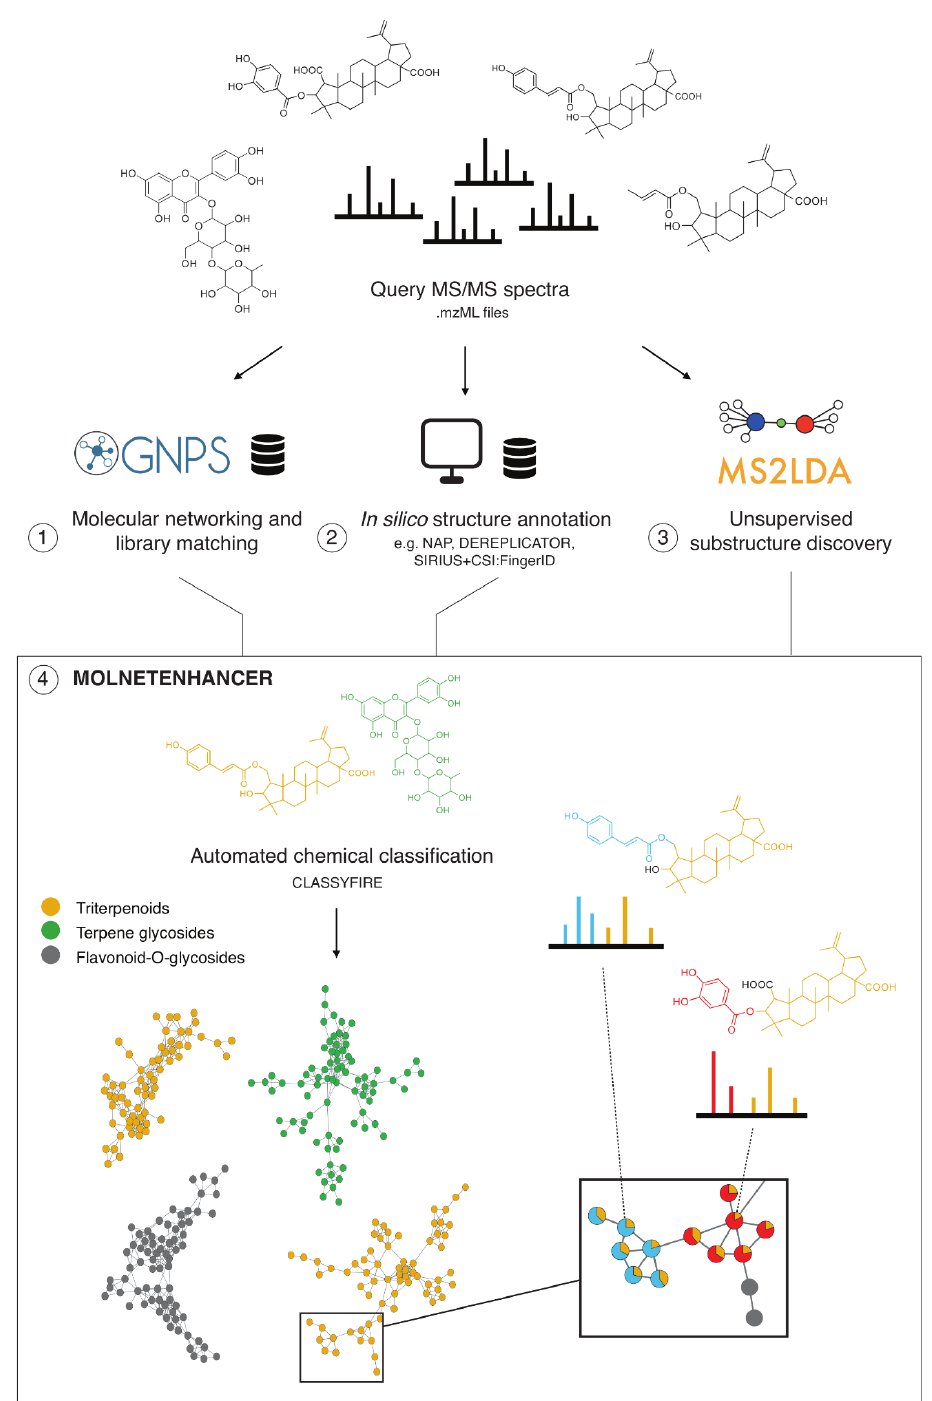
Figure 1. Schematic overview of the MolNetEnhancer workflow. Starting with mass spectrometry data in the mzML format obtained from complex metabolic mixtures the user creates ( 1 ) mass spectral molecular networks in GNPS, ( 2 ) performs in silico structure annotation (e.g., through NAP, DEREPLICATOR or SIRIUS + CSI:FingerID), and ( 3 ) performs unsupervised substructure discovery through MS2LDA. Steps 1–3 are performed prior to the MolNetEnhancer workflow within the respective platforms. MolNetEnhancer is then used in ( 4 ) to map information layers obtained from all three platforms independently on top of each other resulting in network-wide chemical class information and more detailed substructure information within molecular families (as exemplified for the organic acid conjugates in the enlarged part of the triterpenoid molecular family on the